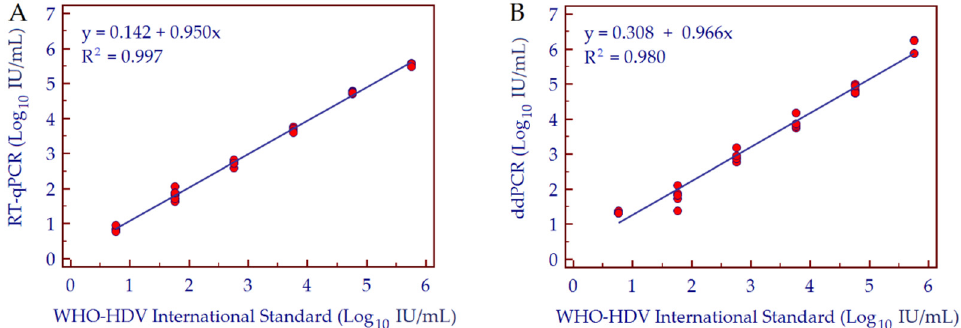
Figure 3. Scatter plot with regression lines between nominal and measured concentration of a 10-fold dilution series of WHO-HDV international standard using real time qPCR ( A ) and ddPCR ( B ). Three replicates were performed per dilution. Abbreviations: hepatitis D virus (HDV); World Health Organization (WHO).